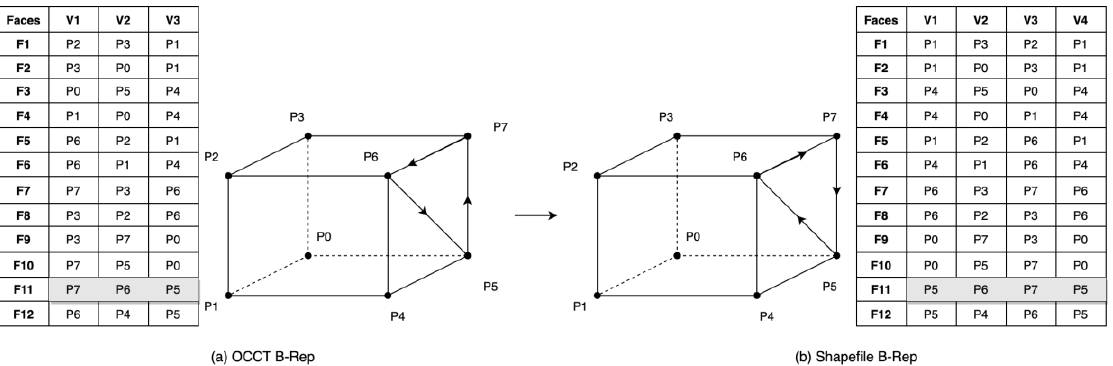
Figure 6. Reversing order of points for converting OCCT B-Rep to shapefile B-Rep. The root of this problem is found to be in the fact that the DirectX, which is the default GPU API used in ArcGIS by ESRI (i.e., the developer of the shapefile format), uses a left-handed coordinate system, while the GPU API used by OCCT, i.e., OpenGL, uses a right-handed coordinate system. Despite the difference in point order, the normal of face (or the positive side of face) is pointing outward in the corresponding system (see Figure 7), which is important for calculating surface area, solid volume, and model rendering [39].